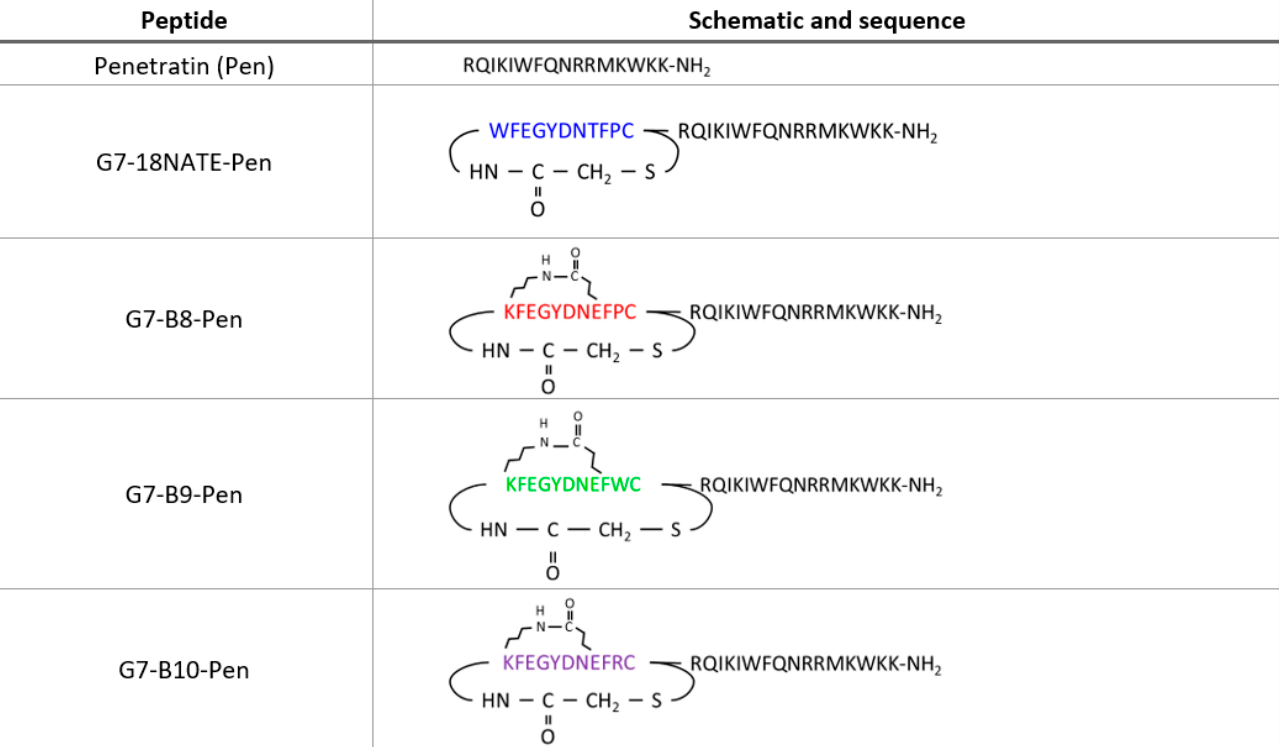
Figure 1. Schematic and peptide sequence of third-generation Grb7-SH2 inhibitors. Shown are schematic representations of the Penetratin-linked peptides used in the current study. The Penetratin amino acid sequence is shown in black single-letter code. The G7 peptide sequences are shown in coloured single-letter code. The thioether linkage that tethers the N-terminal amine to the cysteine side chain and the lactam bridge that tethers Lys1 to Glu8 in the bicyclic peptide are also depicted. Note that binding and structural studies were conducted on G7 peptides synthesized without the Penetratin sequence.